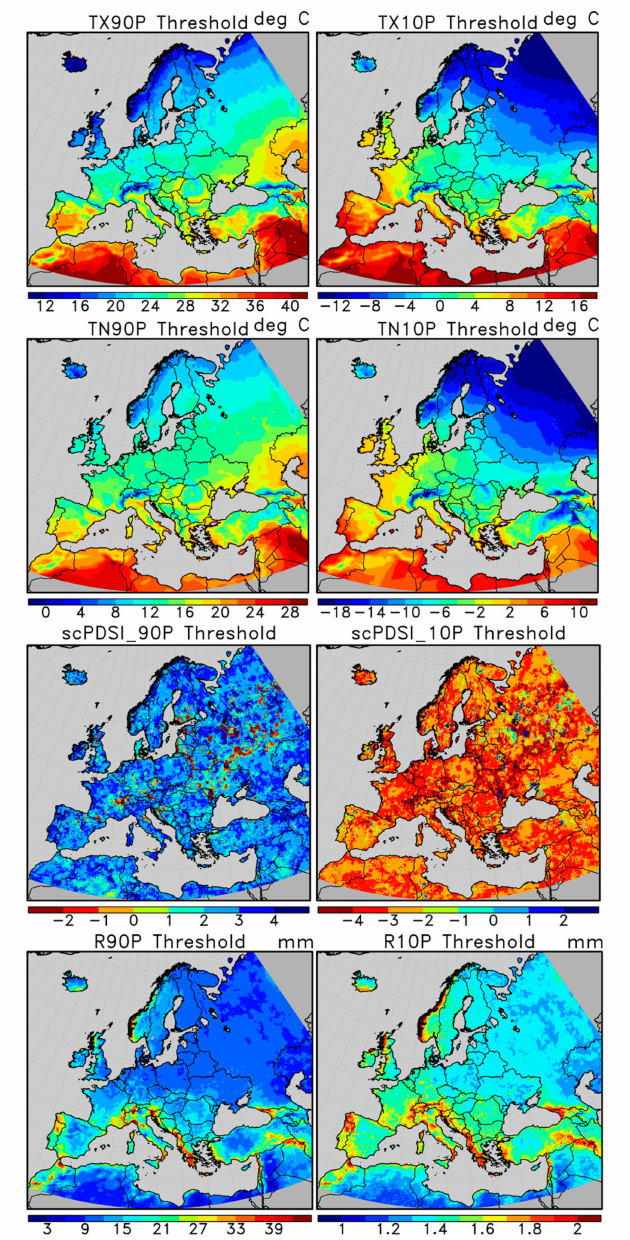
Figure 2. Spatial distribution of the thresholds for the extreme